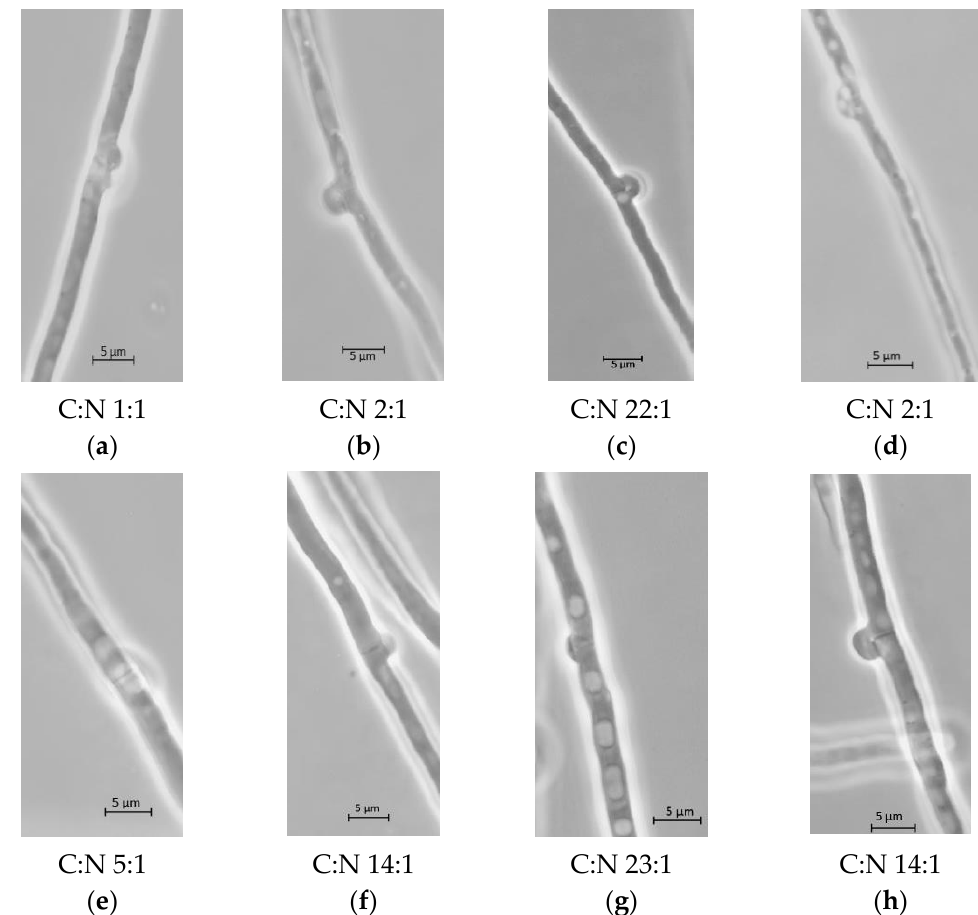
Figure 3. Clamp connection in terminal hyphae from P. ostreatus cultures at seven days of culture using different media compositions: ( a ) glucose and ammonium sulfate 0.5 and 1 gL − 1 ; ( b ) glucose and ammonium sulfate 1 and 1 gL − 1 ; ( c ) glucose and ammonium sulfate 10 and 1 gL − 1 ; ( d ) Glucose and ammonium sulfate 10 and 10 gL − 1 ; ( e ) glucose and YE 5 and 1 gL − 1 ; ( f ) glucose and YE 5 and 10 gL − 1 ; ( g ) glucose and YE 5 and 20 gL − 1 ; ( h ) glucose and YE 10 and 20 gL − 1